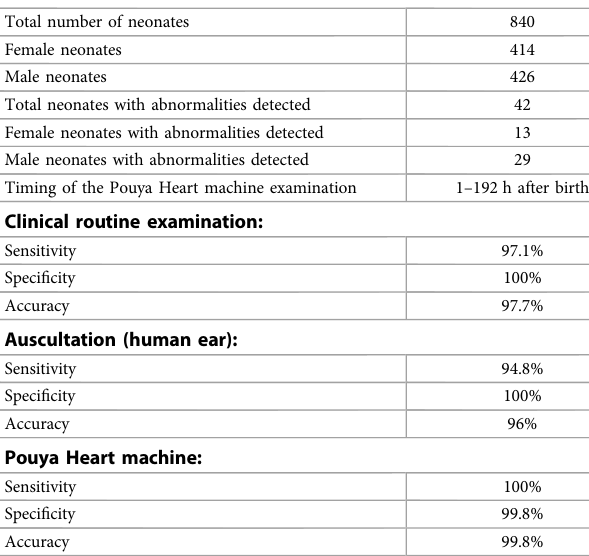
TABLE 2 Data of the 42 patients and the sensitivity, speci fi city, and accuracy of the pouya heat machine, clinical routine examination, and auscultation.